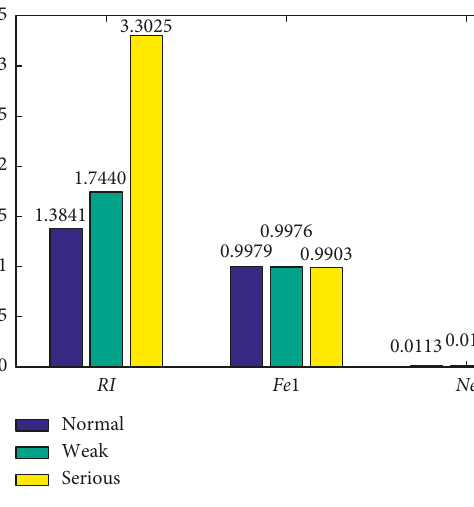
Figure 8: Comparison of experimental results of RI , Fe 1, and Ne under different severities.